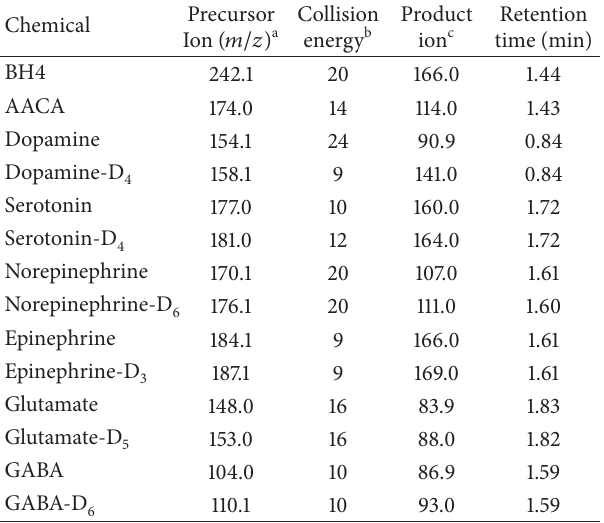
Table 3: The analytic parameters of neurotransmitters by LC-